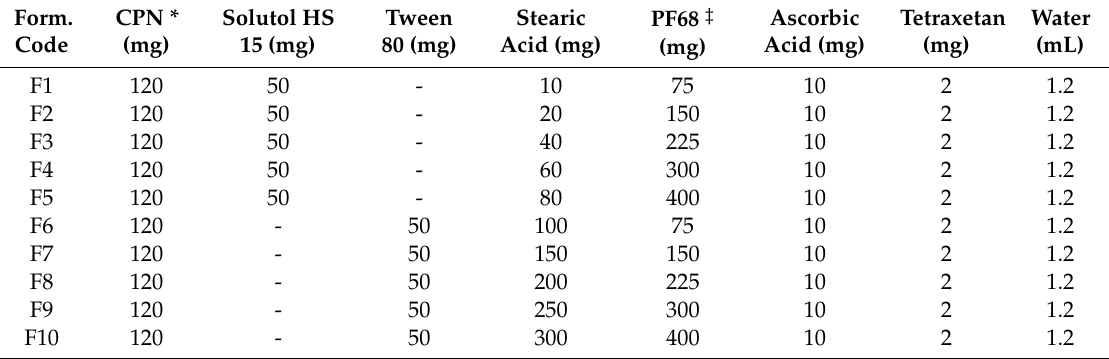
Table 1. Microwave-assisted cisplatin solid lipid nanoparticles for subcutaneous delivery.